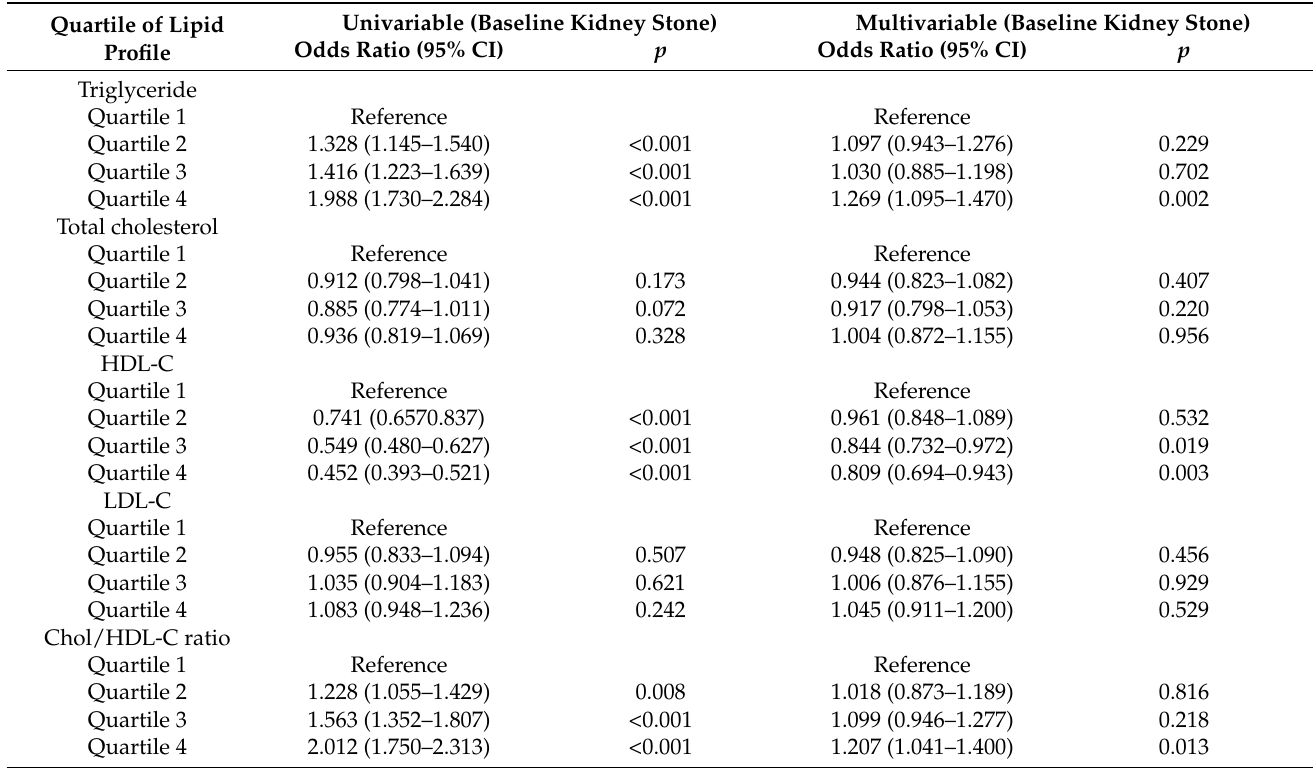
Table 2. Association of quartile of lipid profile and baseline kidney stone disease using logistic regression analysis in all study participants ( n = 27,002).